Question: Briefly state, in one sentence, what is plotted here.
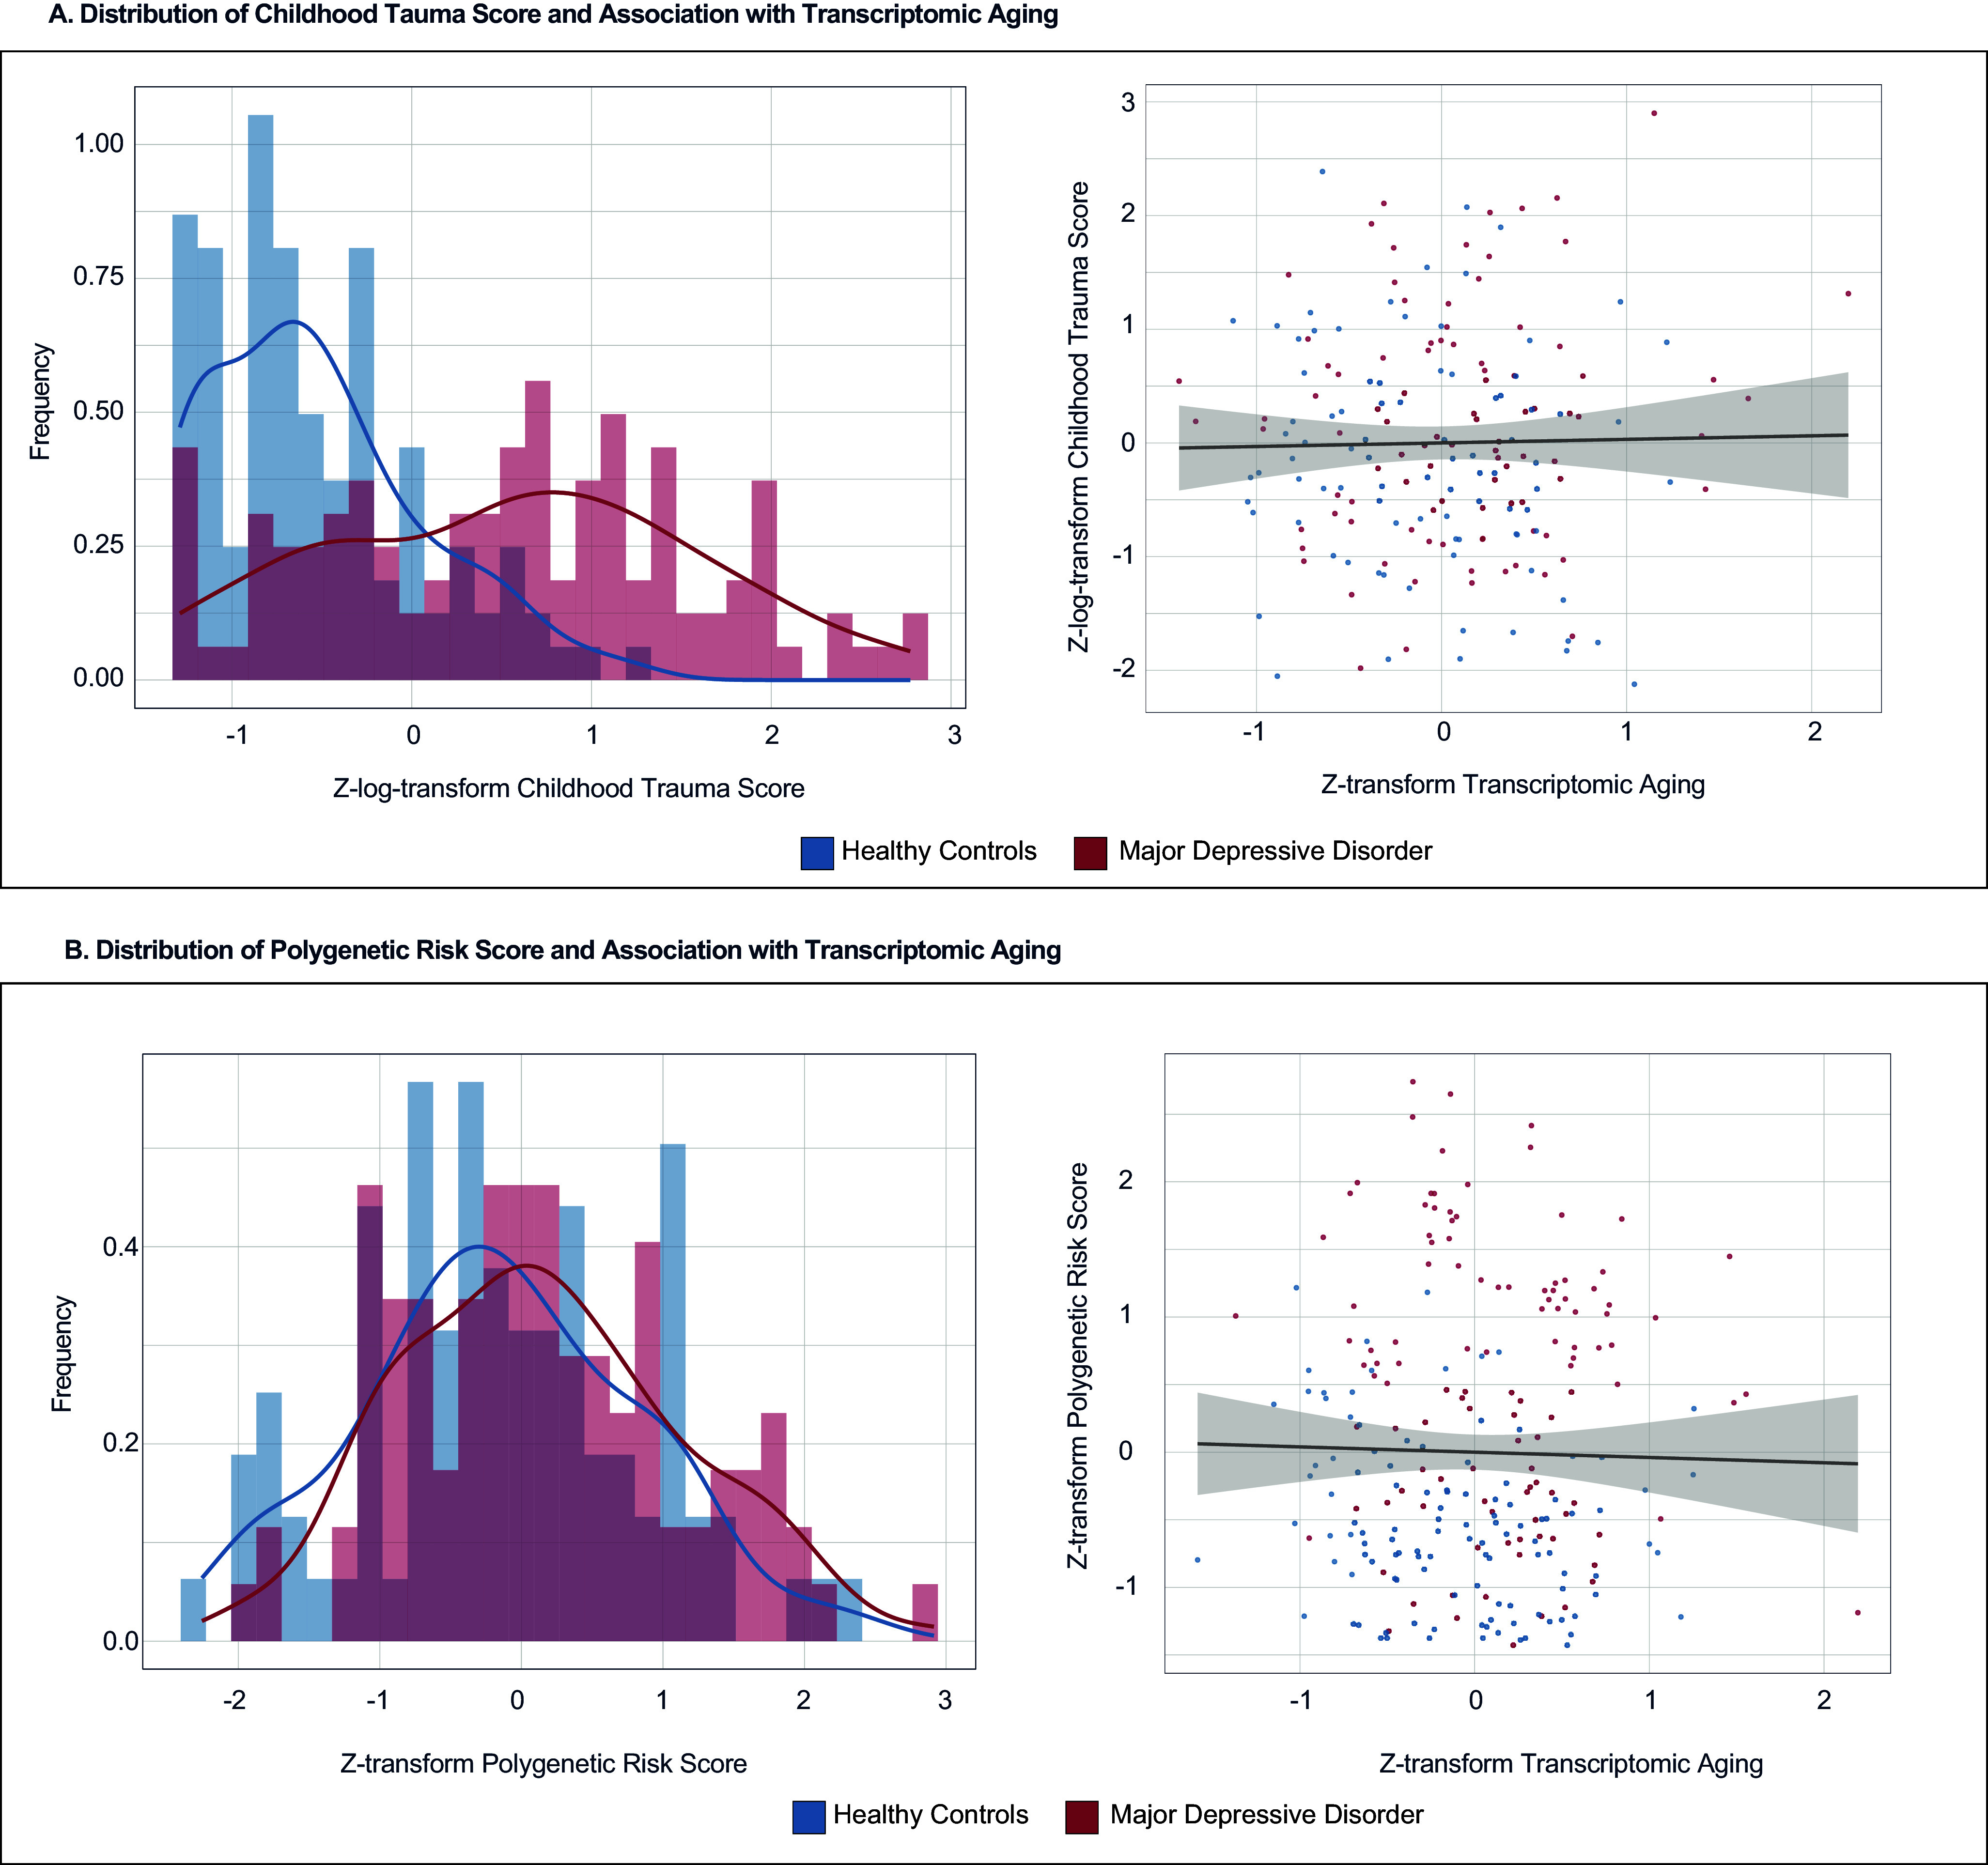
Answer: Distributions of risk factors and their associations with transcriptomic aging. Note : (a) Distribution of childhood trauma scores and their association with transcriptomic aging. The left histogram shows the distribution of childhood trauma scores for MDD and HCs, with density curves overlaid for each group. The right scatterplot illustrates the association between transcriptomic aging and childhood trauma scores, with a regression line and 95% confidence interval. (b) Distribution of PRS and their association with transcriptomic aging. The left histogram presents the distribution of PRS, and the right scatterplot displays the association with transcriptomic aging. Abbreviations: MDD, ‘major depressive disorder’; HCs, ‘healthy controls’; PRS, ‘polygenic risk score’. Figure 4. long description.